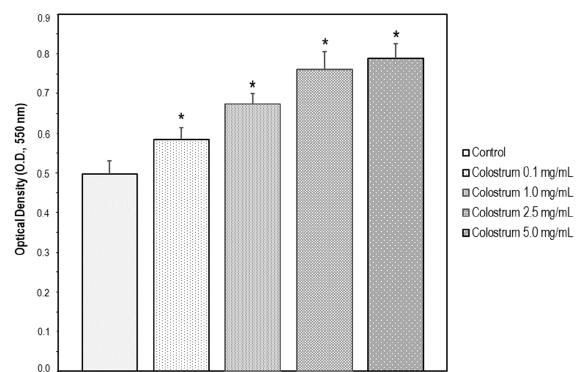
Figure 2. SH-SY5Y cells were treated with Colostrum (0.1, 1.0, 2.5 and 5.0 mg/mL) for 24 h. Then, cell viability was measured by the MTT assay. The data are expressed as the mean ± S.E.M. of three independent experiments. Significant differences were found in OD values elicited by every Colostrum concentration compared to the control untreated cells (Newman–Keuls test, * p < 0.001 vs. control). 2.3. ROS Scavenger Activity of Bovine Colostrum in SH-SY5Y Cells Exposure of the cells to 200–700 µ M DEX µ M for 48 h caused a 30, 46, and 54% increase in fluorescence intensity, respectively, relative to DEX-untreated control cells. A 48 h treatment of the cells with colostrum at a concentration of 1.0 mg/mL plus DEX diminished the fluorescence intensity by 21 and 38%, respectively, in comparison with the cells exposed to 400 and 700 µ M DEX. No significant changes in fluorescence intensity versus control cells were detected in non-stressed cells treated only with the bovine colostrum (Figure 3).